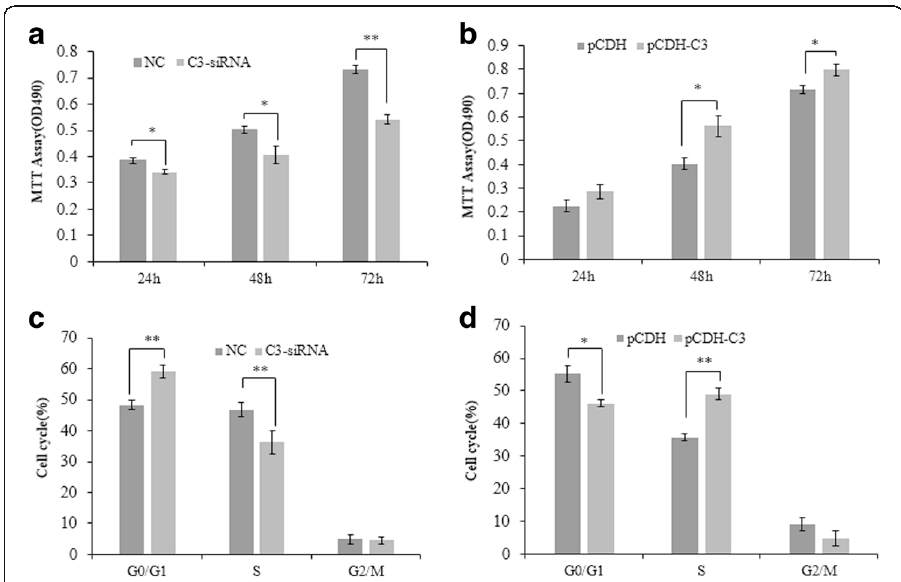
Fig. 3 C3orf43 promotes hepatocyte proliferation and cell growth. a The cell viability was assessed using the MTT assay 24, 48 and 72 h after transfection with siRNA. b The cell viability was assessed using the MTT assay in cells with overexpression of pCDH-C3orf43. c Cell cycle distribution in the C3-siRNA and negative control (NC) groups, C3-siRNA vs. NC (S %: 36.31 ± 1.3% vs. 46.80 ± 1.1%, p < 0.01). d Cell cycle distribution in the pCDH-C3 and pCDH groups, pCDH-C3 vs. pCDH (S %: 49.25 ± 1.7% vs. 35.78 ± 1.2%, p < 0.01). The experiments were performed three times with three replicates in each case. The data are shown as the means ± SD. * p < 0.05, ** p < 0.01 difference relative to the